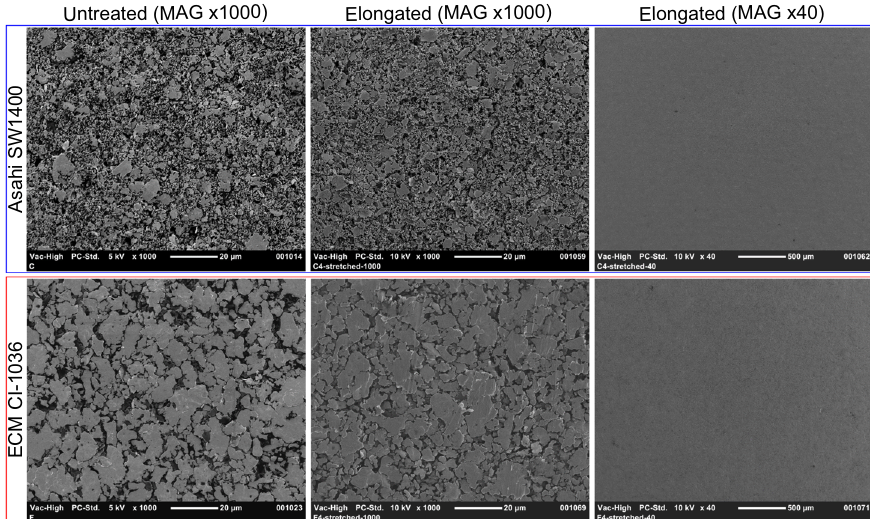
Fig. 4 SEM images of the two best-performing pastes before and after the elongation cycles — full coverage electrodes. The fi gures illustrate no substantial changes on the surface of the electrodes before and after the cycling. The large area fi gures (MAG ×40) demonstrate a smooth surface, free from cracks or dents, regardless of the paste used.